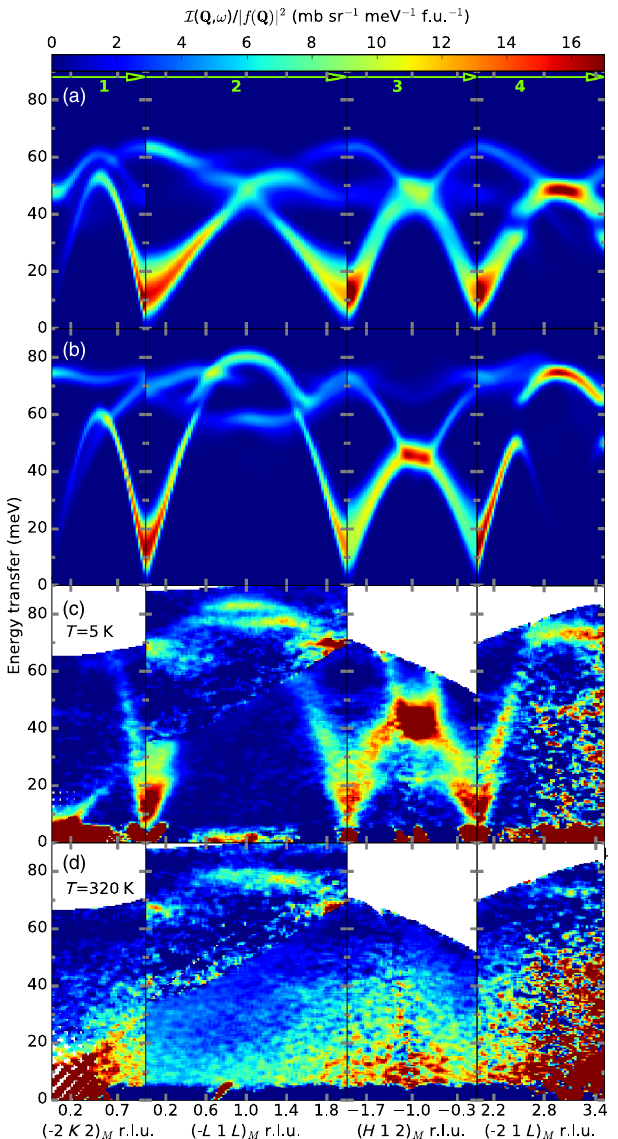
FIG. 9. (a),(b) Neutron scattering intensity associated with spin waves along four high-symmetry directions marked in Fig. 2 calculated with S PIN W [59] for exchange constants shown in Table III. (c),(d) INS cross section measured at 5 and 320 K ¼ 100 meV). Data from multiple Brillouin zones were ( E i assembled to cover the largest possible range of energy transfer. As before, the data were divided by the squared magnetic form factor for presentation and the incoherent background was subtracted from the data (Appendix A